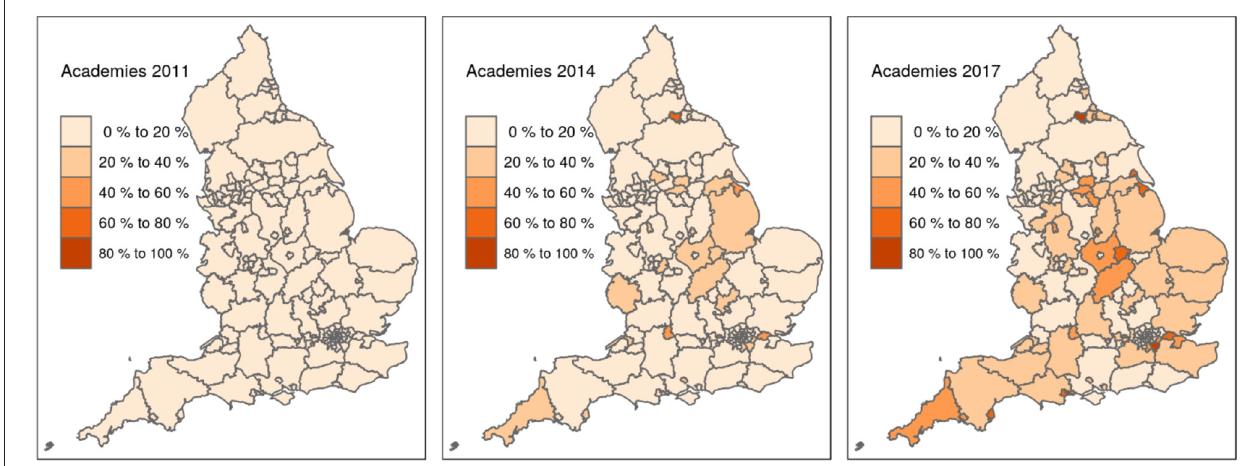
FIGURE 2 | Percentage of academies among English primary schools by local authority in 2011, 2014, and 2017.